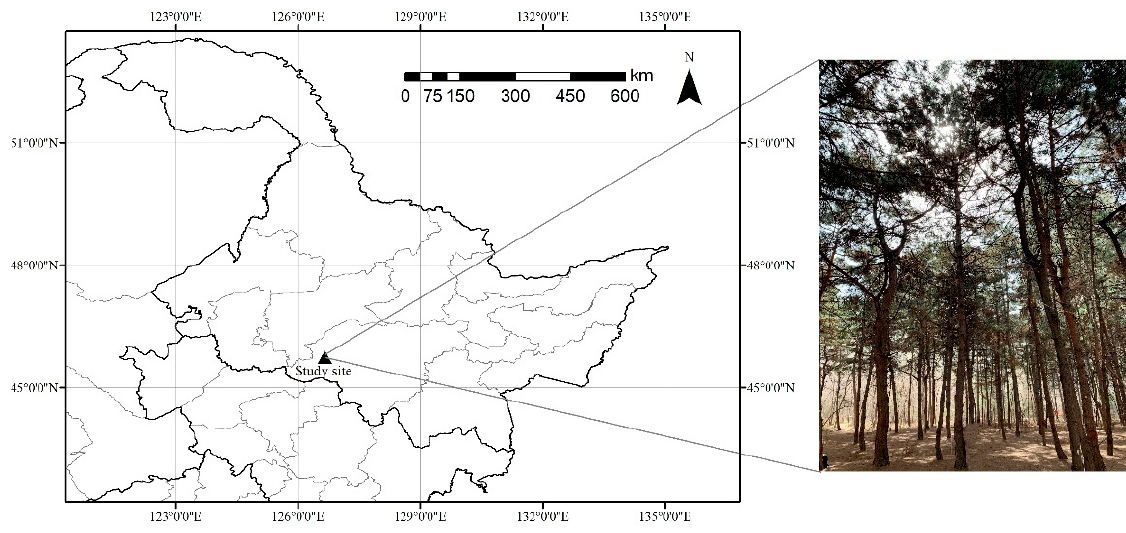
Figure 1. Location of the study area. Table 1. Technical specifications of ZEB-REVO handheld laser scanning system.